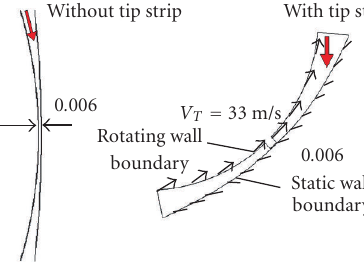
Figure 13: E ff ect of tip strip on rotor-casing leakage.